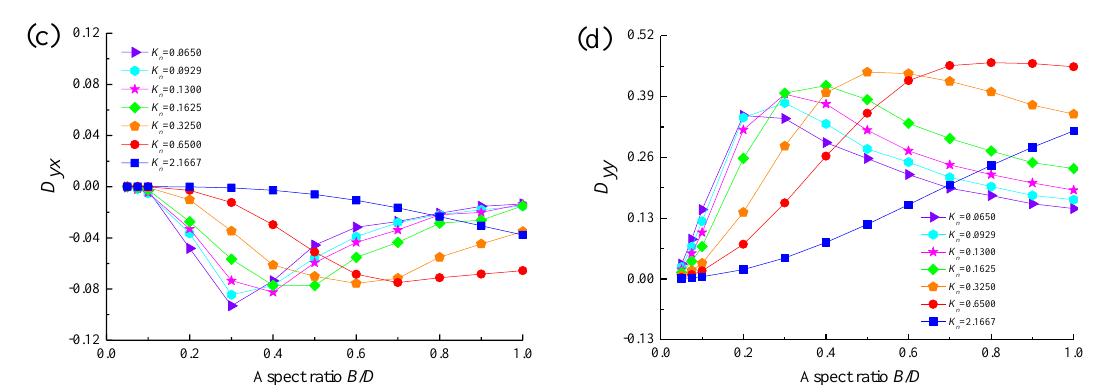
Figure 14. Damping coefficients of Boltzmann model against the aspect ratio B / D for various Knudsen numbers. ( a ) K xx vs. B / D ; ( b ) K xy vs. B / D ; ( c ) K yx vs. B / D ; ( d ) K yy vs. B / D.